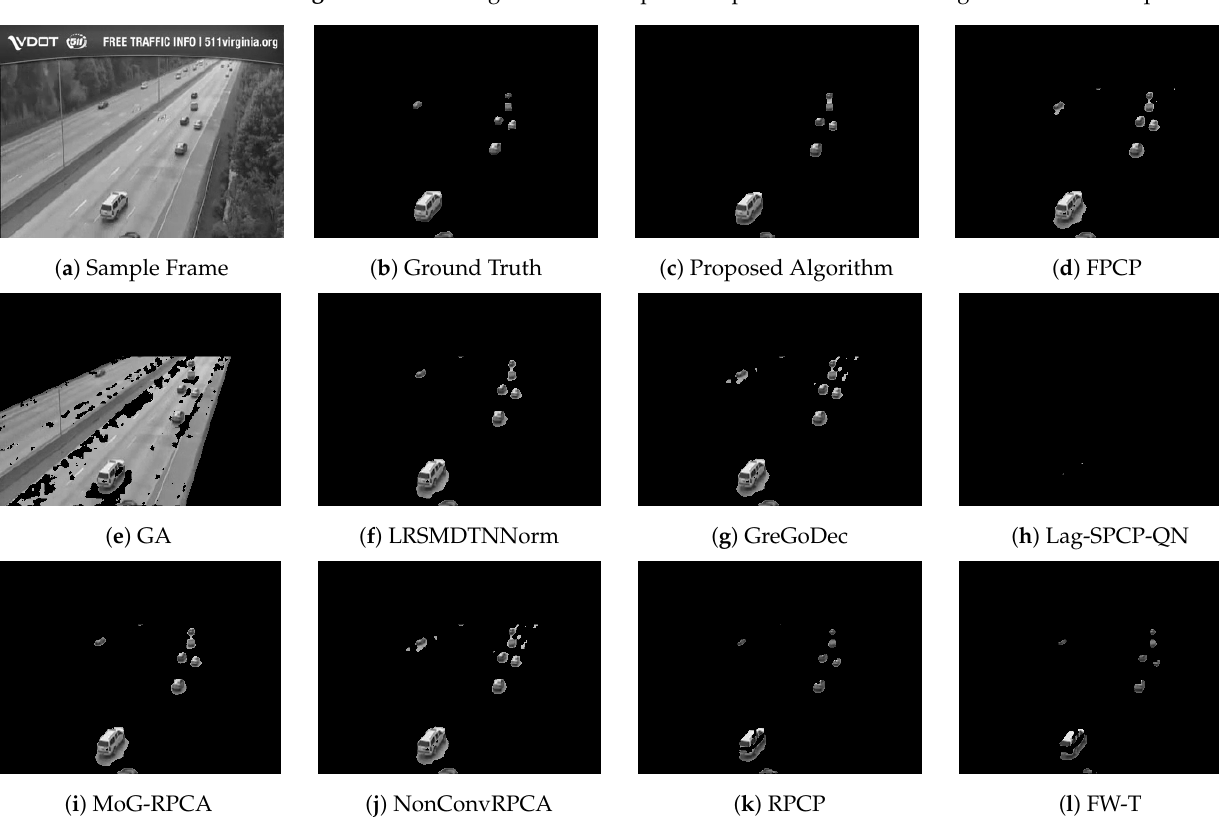
Figure 9. Video 3 segmentation outputs comparison for different segmentation techniques.